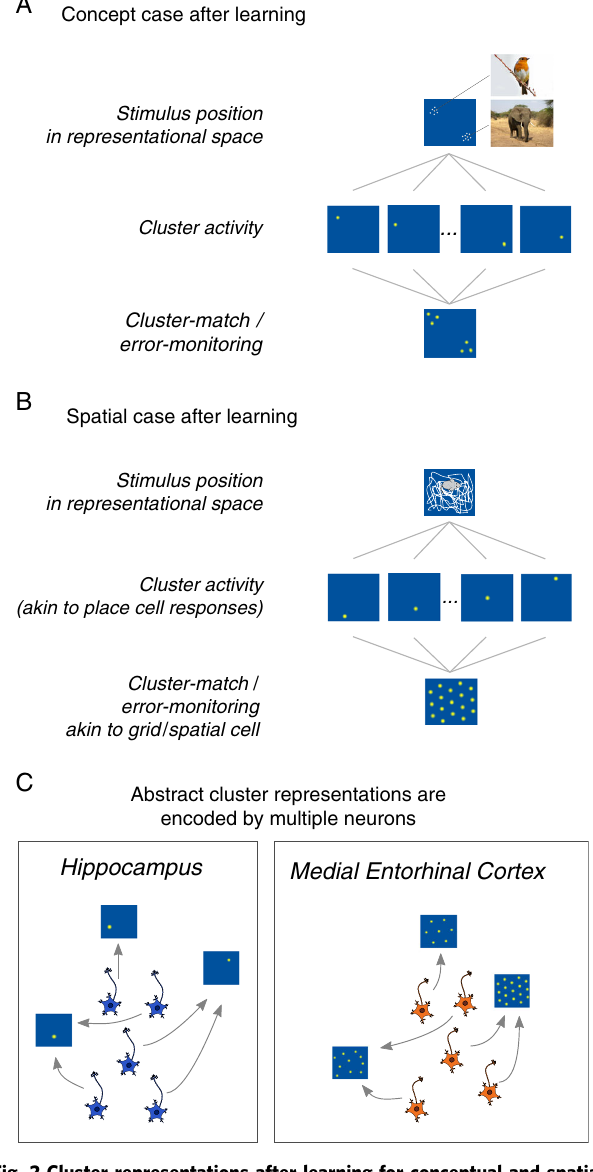
distribution of the clusters. Abstract cluster representations are instantiated by multiple cells in the hippocampus and medial entorhinal cortex (mEC) with similar fi ring fi elds to represent the same location (or concept) in the case of hippocampal cells or cluster match in the case of mEC